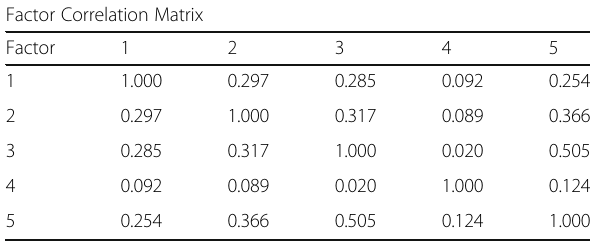
Table 5 Factor correlation matrix of the extracted factors from the indicators of the latent variables in structural equation